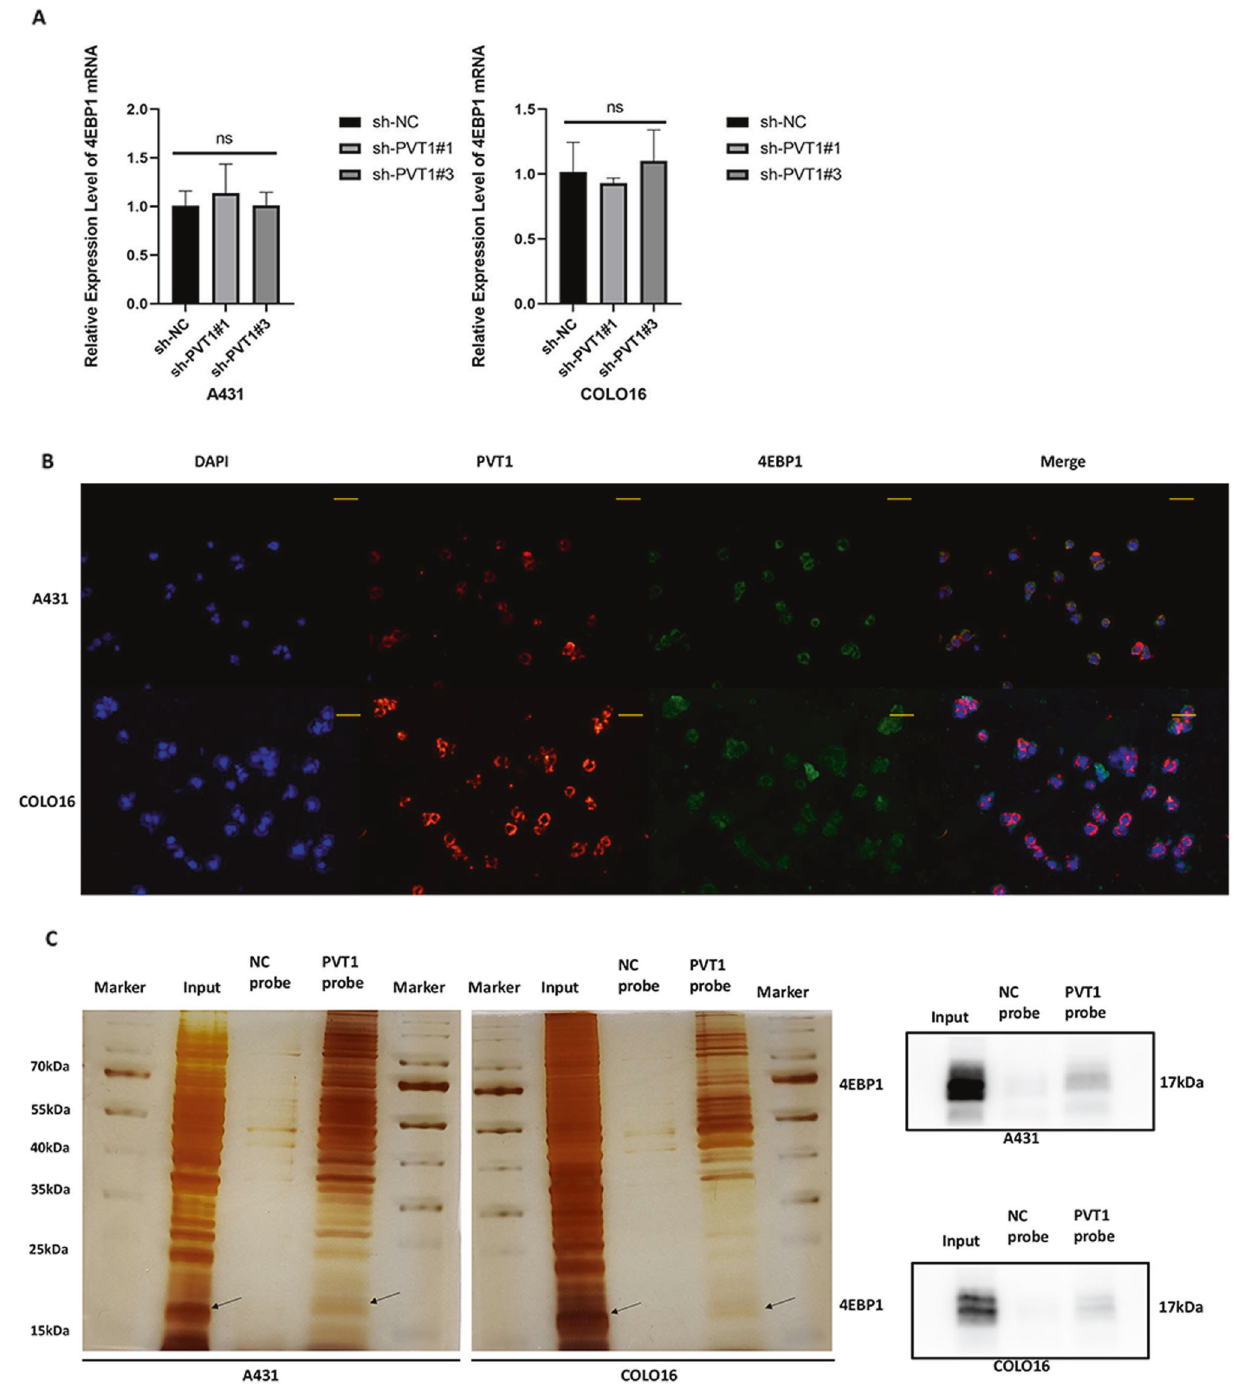
Fig. 6 LncRNA PVT1 interacts with 4EBP1 in A431 and COLO16 cells. A 4EBP1 mRNA expression is measured by RT-qPCR in PVT1- knockdown A431 and COLO16 cells. B Immuno fl uorescent images combined with RNA-FISH staining in A431 and COLO16 cells (×200 magni fi cation, scale bar = 50 µm). C 4EBP1 was identi fi ed as the PVT1-interacting protein by RNA pull-down assays. Proteins pulled down by the PVT1 probe, or its negative probe were separated by SDS-PAGE and subjected to silver staining. A speci fi c band, marked with an arrow, was identi fi ed as 4EBP1 protein in the PVT1 group. WB detection of 4EBP1 after PVT1 RNA pull-down assay. ns no statistical signi fi cance. trend following 4EBP1 overexpression (Fig. 8B). These fi ndings were reversed the expression of these targets induced by PVT1 knock- all in accordance with observed phenotype experiments. Thus, these down in both A431 and COLO16 cells (Fig. 8A). Moreover, Snail, N- outcomes further support our hypotheses that 4EBP1 can regulate cadherin, MMP-2, and MMP-9 were downregulated and E-cadherin several downstream functional proteins to typically reverse the cell were upregulated in sh-PVT1#3/Vector groups (Fig. 8B), suggesting functions induced by PVT1 knockdown, indicating PVT1 modulate PVT1 knockdown can inhibit metastasis and invasion. Also, these 4EBP1 to promote cSCC carcinogenesis. These data further metastasis and invasion markers expression displayed a reversed